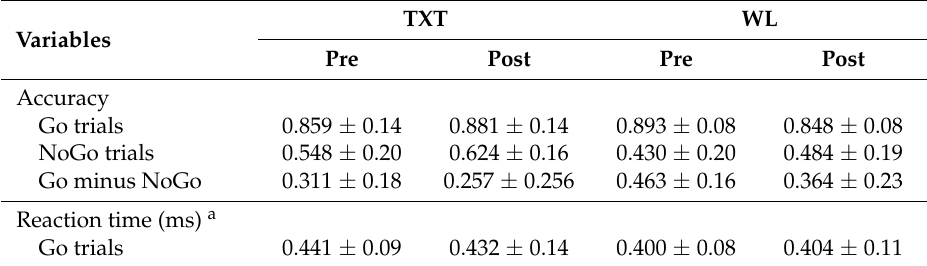
Table 2. Mean ( ± SD) performance data at pre-test and post-test sessions. Table 2. Mean (±SD) performance data at pre-test and post-test sessions.